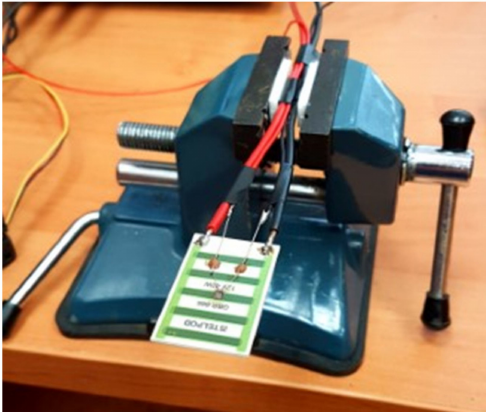
Figure 2. General view of the investigated resistor with a mounted temperature